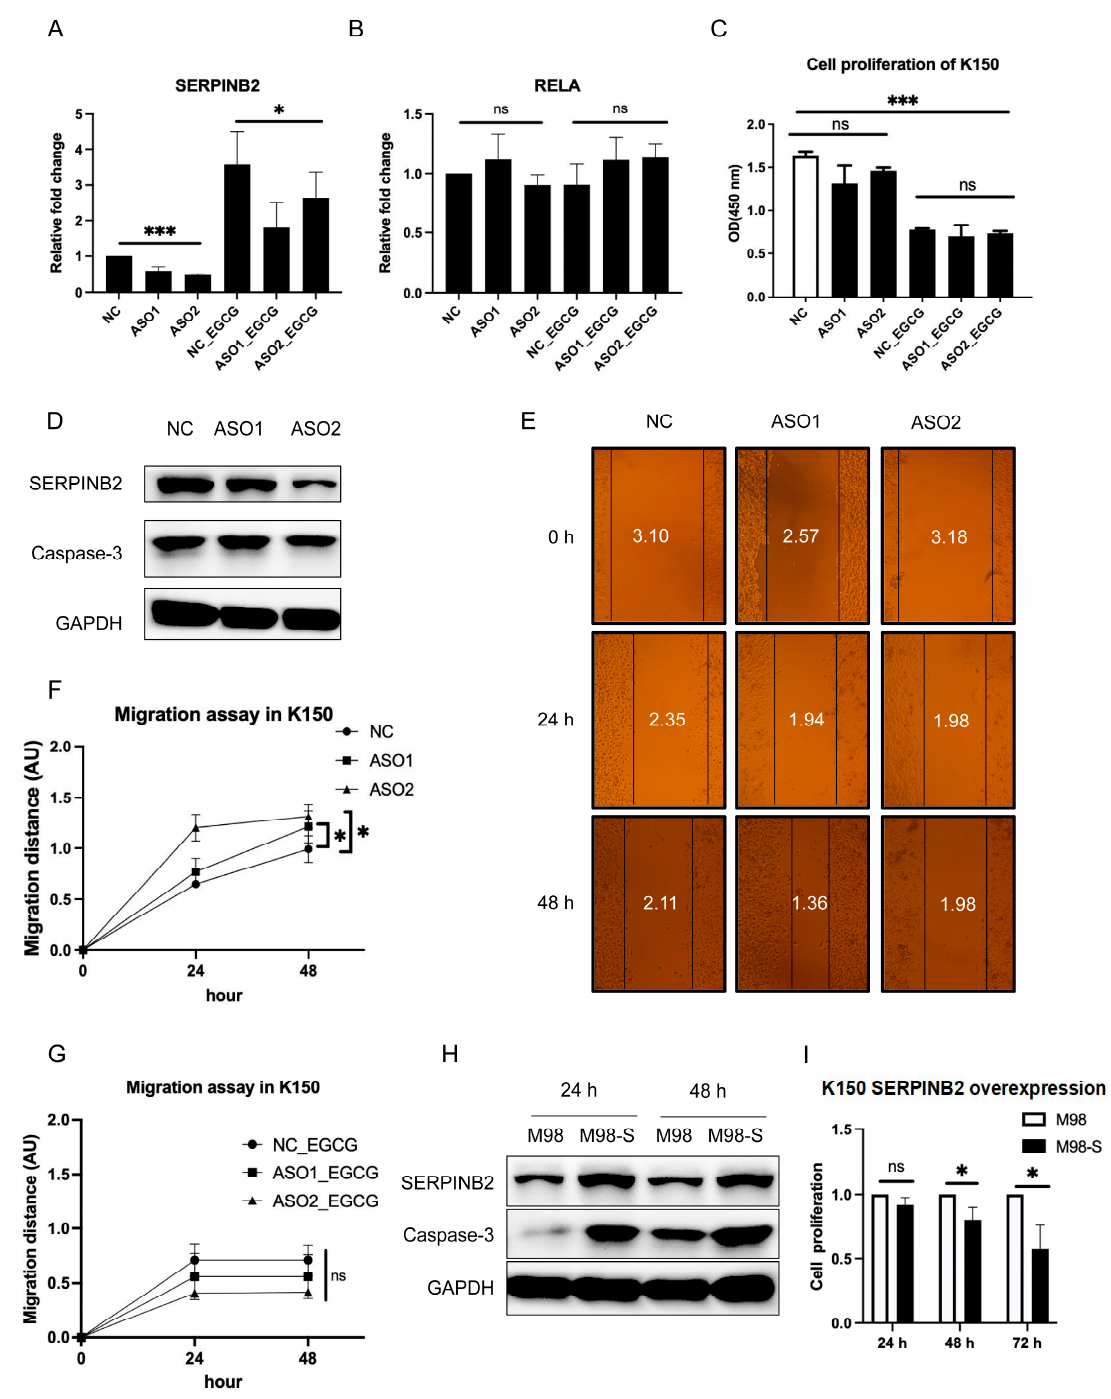
Figure 4. SERPINB2 is associated with cell migration and apoptosis in KYSE150. A-B. Rela- tive fold change of SERPINB2 ( A ) and RELA ( B ) 24 h after knockdown with antisense oligonu- cleotide (ASO) targeting SERPINB2. ( C ) Cell viability after ASO-mediated knockdown of SERPINB2. ( D ) Western blotting showing down-regulation of SERPINB2 and Caspase-3 after SERPINB2 knock- down. ( E ) Wound healing assay showing cell migration after SERPINB2 knockdown without EGCG treatment. ( F , G ) Statistical analysis for cell migration distance of three independent assays without ( F ) or with ( G ) EGCG. ( H ) Western blotting showing up-regulation of SERPINB2 and Caspase-3 after SERPINB2 overexpression. ( I ) Cell viability determined by CCK8 assay after SERPINB2 overexpres- sion. Data are shown as mean ± SD. n = 3, *: p < 0.05; ***: p < 0.001, ns: not